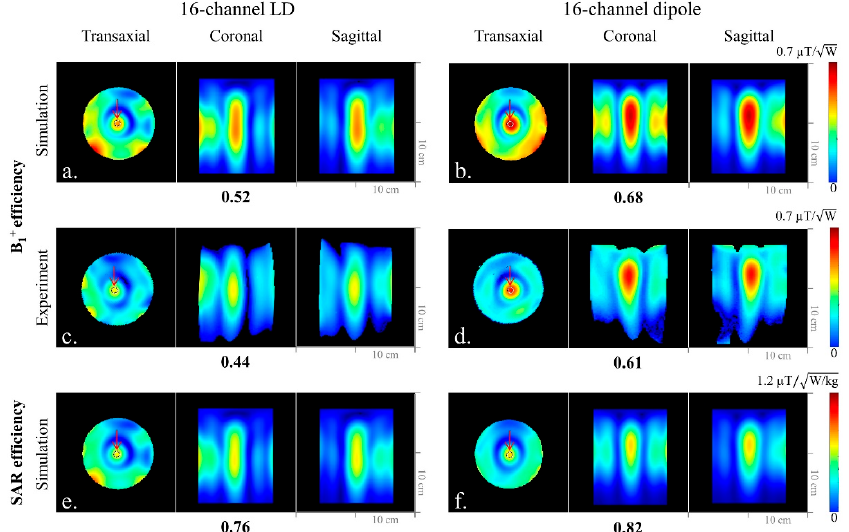
Figure 6. Simulated B 1+ efficiency ( a , b ), experimental B 1+ efficiency ( c , d ), and SAR efficiency ( e , f ) maps of the 16 ‐ channel LD and dipole antenna arrays with a cylindrical phantom in the transaxial, coronal, and sagittal planes, respectively. The number below each subfigure was the value from the ROI indicated in each transaxial plane.